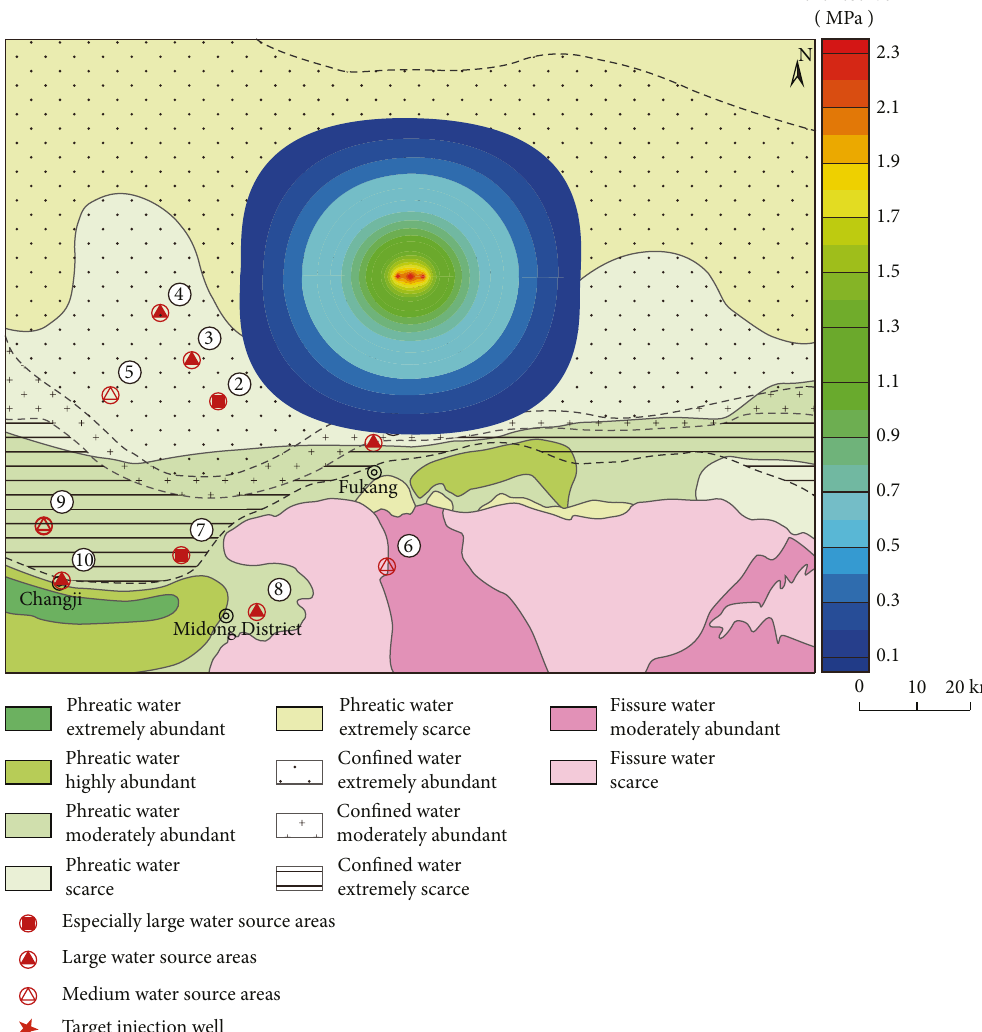
Figure 31: Pressure increase in the CO